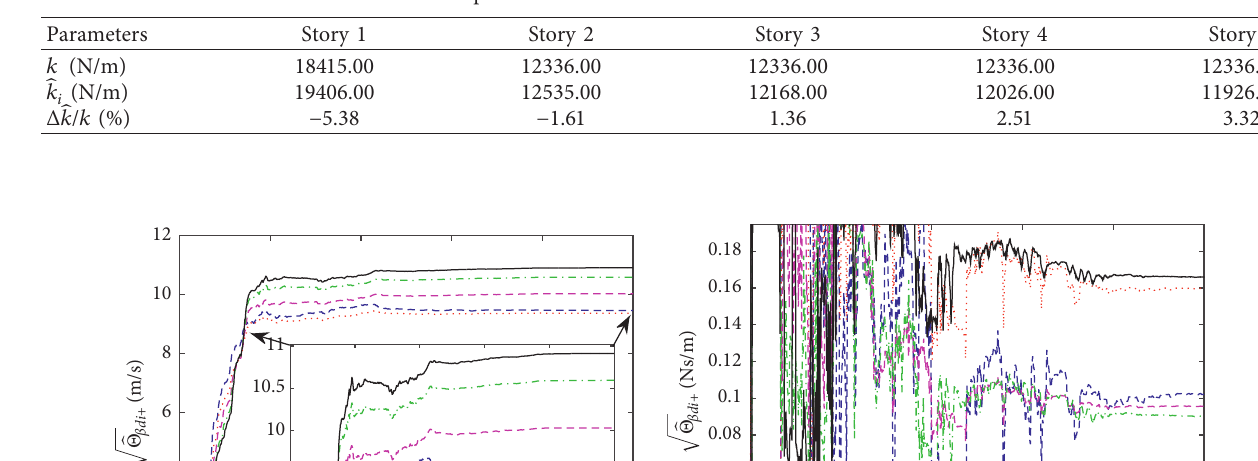
Figure 6: Identified parameters from the discrete shear beam. (a) Evolution of identified Table 2: Comparison between lateral stiffness and estimated stiffness.